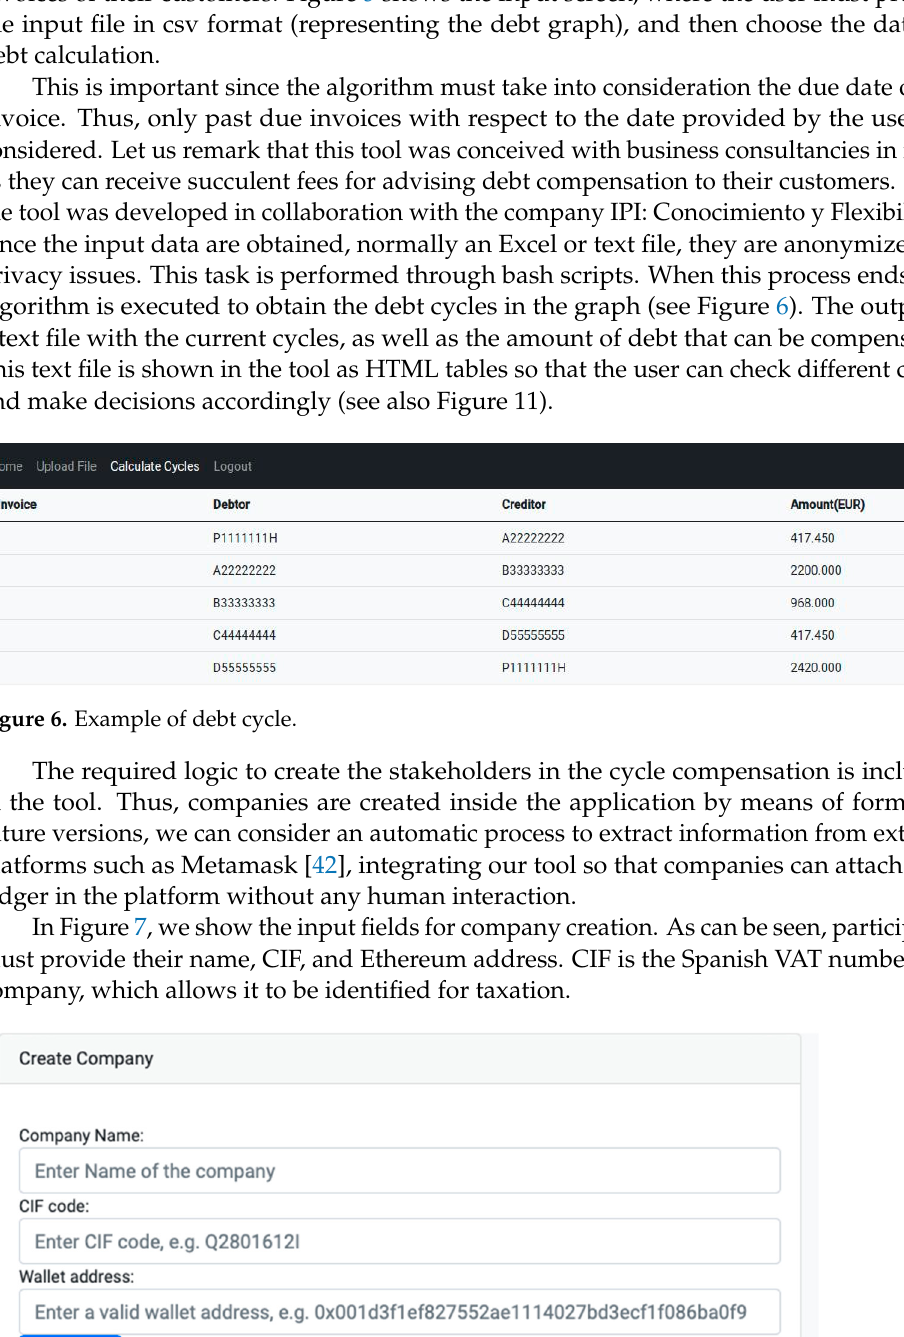
Figure 8. Transaction for company creation in Ganache. Moreover, a new block is added to the blockchain (see Figure 9). This logic is inter- nally provided using the Web3 library. Figure 9. Added block after company creation in Ganache. Each company has a Solidity smart contract with three variables: the name of the company, its CIF, and a mapping from the Ethereum address and debts, i.e., an array where the indices are the debtor’s address, and the value is the amount of debt in EUR. This mapping can be seen as a sort of accounting for the debts of a specific company. Let us note that we internally calculate the correspondence between Ethers and EUR. On the other hand, if the user (normally, the consultant) asks for a cycle compensa- tion, the tool automatically calls the corresponding method of the creditor smart contract, called “cancelInvoice”, in order to reduce the amount of debt in the previously presented mapping. This method is invoked for each invoice in the cycle. As previously mentioned,